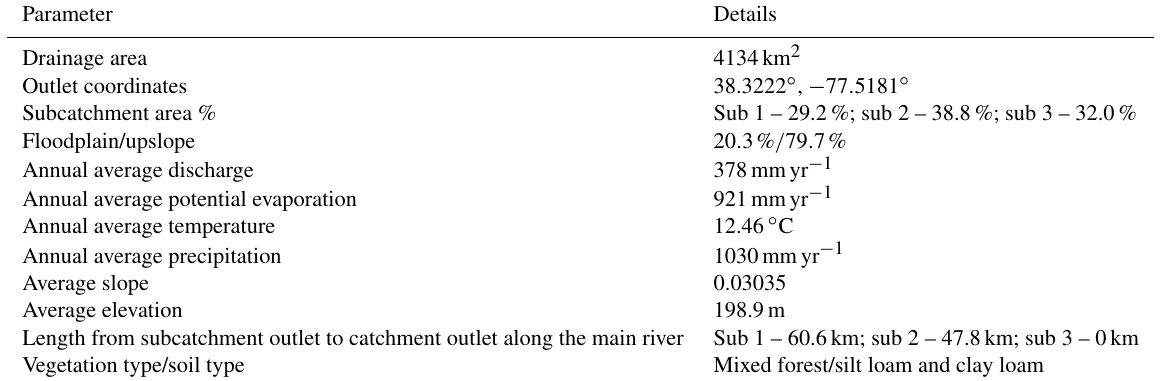
Table 2. Basin details.